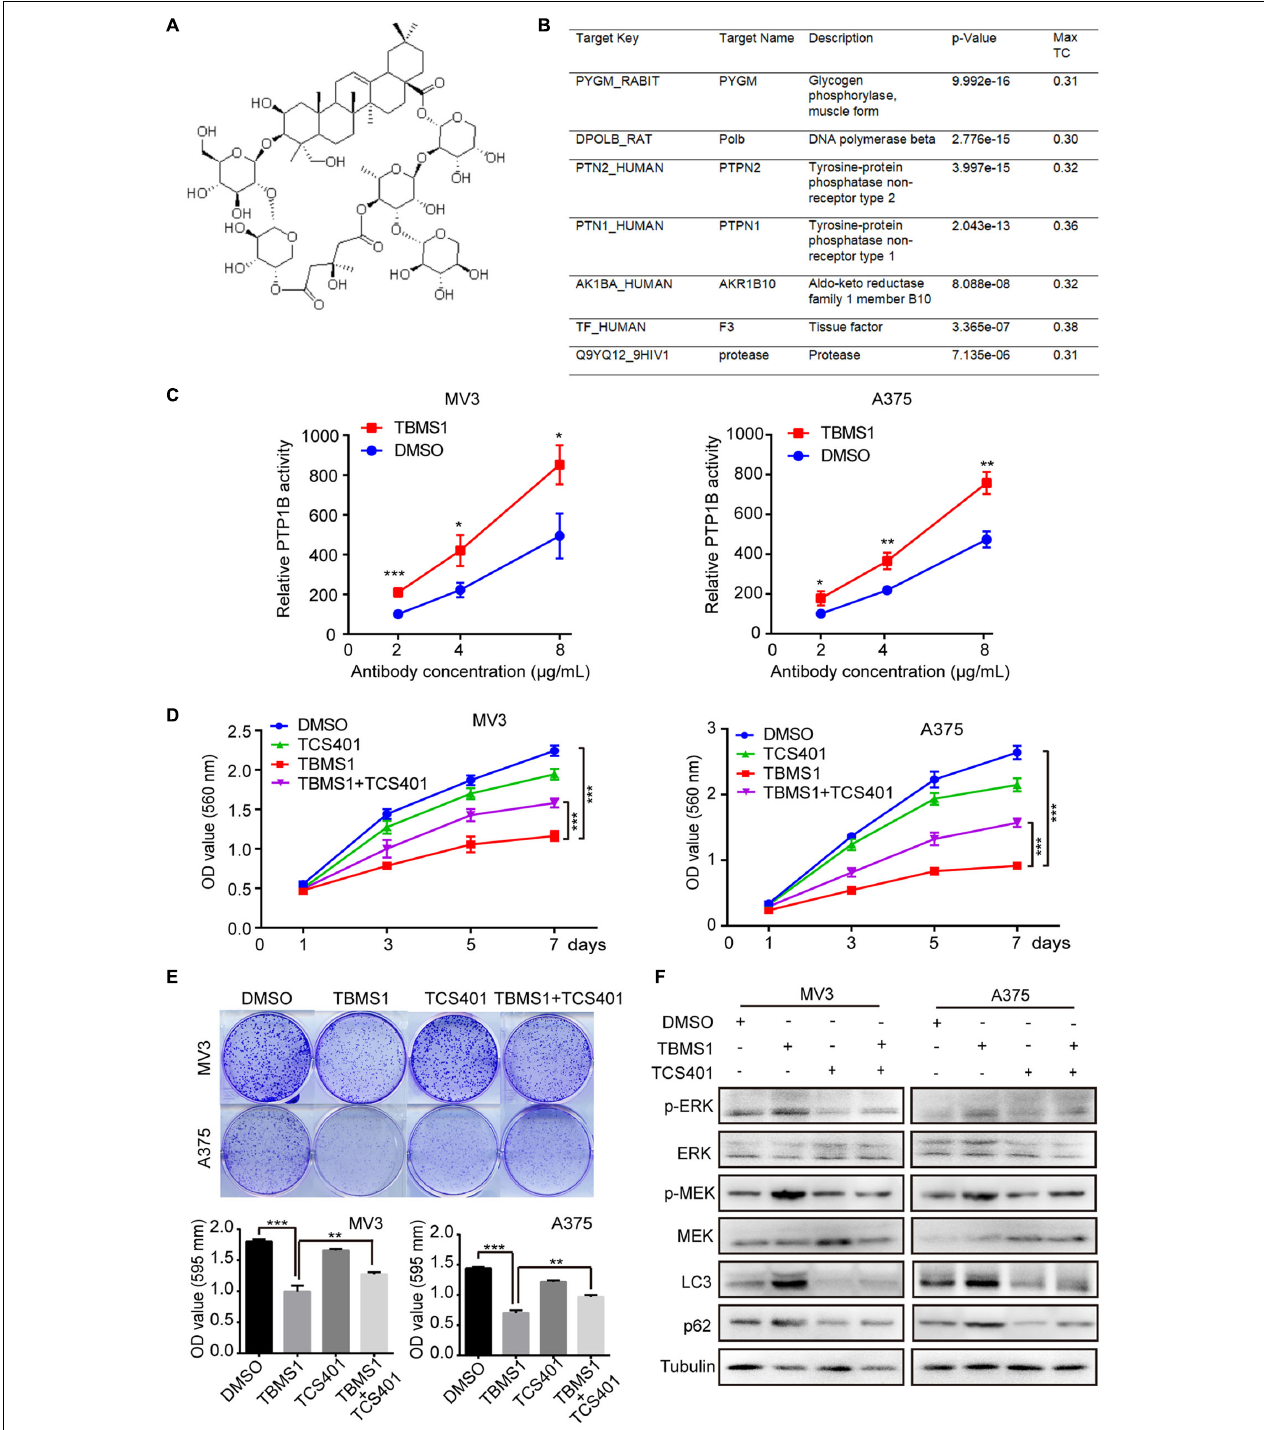
FIGURE 7 | TCS401 rescued TBMS1-induced anti-melanoma activities. (A) The structure of TBMS1. (B) Target prediction results from ZINC database. (C) MV3 and A375 cells were treated with 12 and 8 µ M TBMS1 for 48 h and then lysed. Relative activity of PTP1B (% of DMSO + 2 µ g/mL antibody) was detected by immunoprecipitation technique and specific substrate. The absorbance was read at 405 nm by the microplate reader. Negative control was sample without PTP1B enzyme. (D) Growth curve of MV3 and A375 cells treated with TBMS1 and 2 µ M TCS401. DMSO was used as control. (E) Clonogenicity of MV3 and A375 cells treated with TBMS1 and 2 µ M TCS401. The formation of clones after 10 days culture. On the below is the quantitative figure of clonogenic assay results. (F) The expression level of p-ERK1/2, ERK1/2, p-MEK1/2, MEK1/2, LC3B, and p62 in melanoma cells treated with TBMS1 and 2 µ M TCS401 for 48 h. A two-tailed unpaired Student’s t -test was carried out. * p < 0.05, ** p < 0.01, *** p < 0.001, **** p < 0.0001.